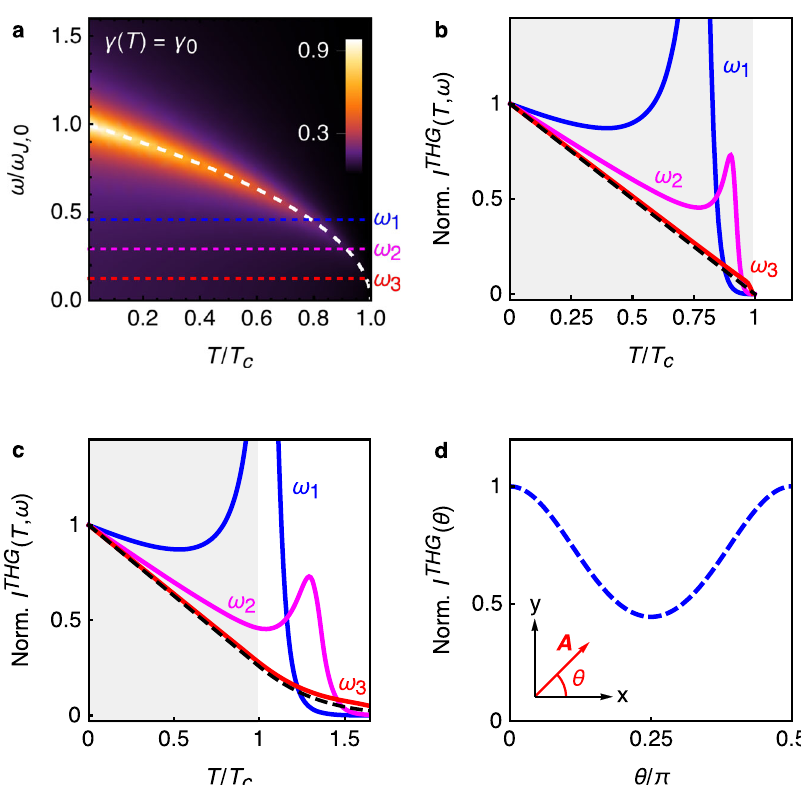
Fig. 3 Non-linear excitation of in-plane JPM. a Temperature and frequency dependence of the non-linear kernel ∣ K ∥ (2 ω , T ) ∣ , normalized to its T = 0 value for the pumping frequency ω = ω J ,0 , for constant damping γ . The dashed line denotes ω k J ð T Þ = ω k J ; marked in a , normalized to I THG ( ω i , 0). The dashed line represents J ∥ ( T )/ J ∥ (0). As one can see, when ω k J ; approaches the temperature dependence of the stiffness. c Effect of superconducting fl uctuations on the THG. Here the dashed line simulates the experimental behavior of the J ∥ ( T ) measured at THz frequencies, with a pronounced tail above T c . When ω k J ; above T c , following the fl uctuating stiffness. d Angular dependence of I THG ( θ ) = ∣ K ( θ ) ∣ 2 , where K ( θ ) is given by Eq.